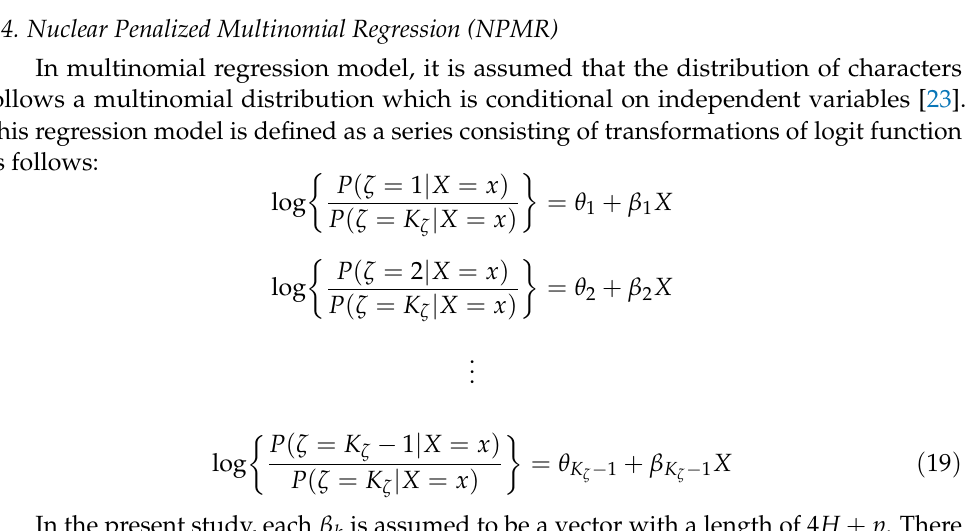
Figure 1. Structure of support vector